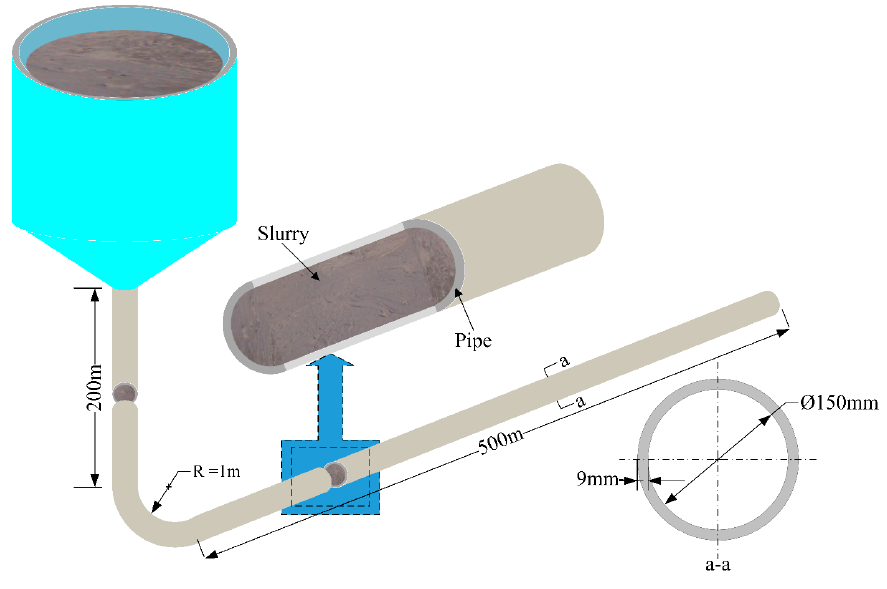
Figure 4. The diagram of the pipeline transport system.